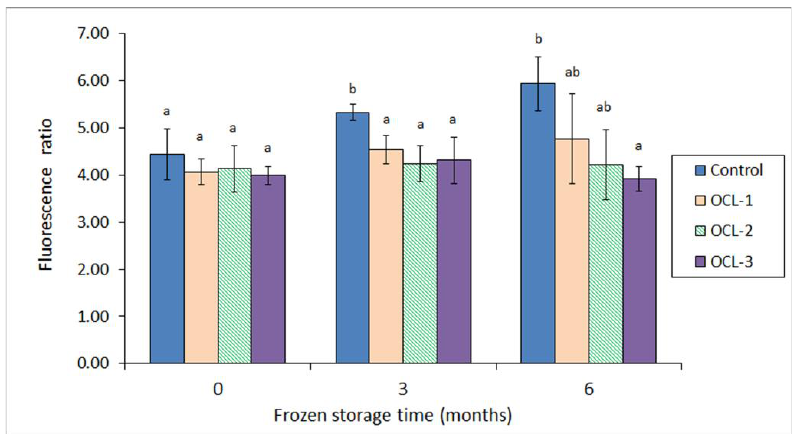
Figure 4. Fluorescent compound formation (i.e., fluorescence ratio) in canned jack mackerel previously subjected to different frozen storage times (0, 3 and 6 months). For each frozen time, different lowercase letters denote significant differences ( p < 0.05) as a result of the packing medium employed. Packing media: Control (water), OCL-1, OCL-2 and OCL-3 (low-, medium-, and high-concentrated octopus cooking liquor, respectively). Adapted from Méndez et al. [96].